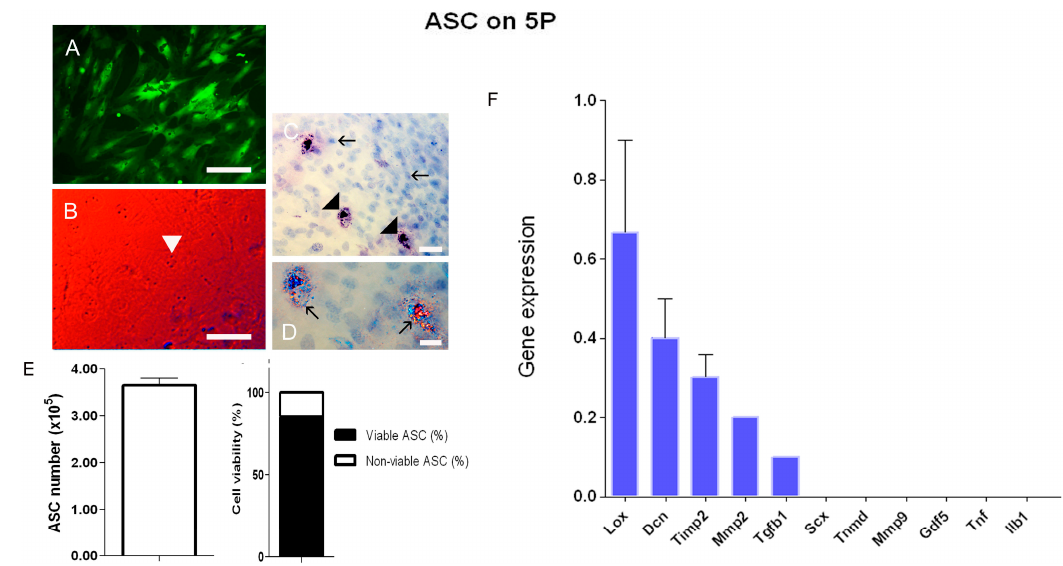
Figure 2. Morphology of ADMSC on 5P: ( A ) ADMSC-GFP: Fibroblast-like morphology, with a fusiform shape. ( B ) Contrast by Differential Interference (DIC): The red to blue band showing the interference effect of the nucleus due to higher concentrations of material. Nucleoli presence seen in the initial of the blue band ( (cid:73) ). ( C ) ADMSC stained with AT (pH 4.3): Note the presence of nuclei stained in blue ( → ), and the presence of granules of various sizes highly stained in blue in some regions ( (cid:73) ) due to the disponibility of phosphate groups. ( D ) Polarization microscopy: In the detailed image, note the abnormal interference colors due to abnormal dispersion of birefringence because of the differences in the high packing of DNA. Bars = 50 µ m ( A ), 70 µ m ( B , C ), and 35 µ m ( D ). ( E ) Number of ADMSC used for application in tendons, presenting about 80% viability after tripsinization. ( F ) RT-PCR array of ADMSC on 5P in vitro showing the expression profile of the genes Lox , Dcn , Timp2 , Mmp2 , and Tgfb1 . No expression was observed for Scx , Tnmd , Mmp9 , Gdf5 , Tnf , and Ilb1 genes .